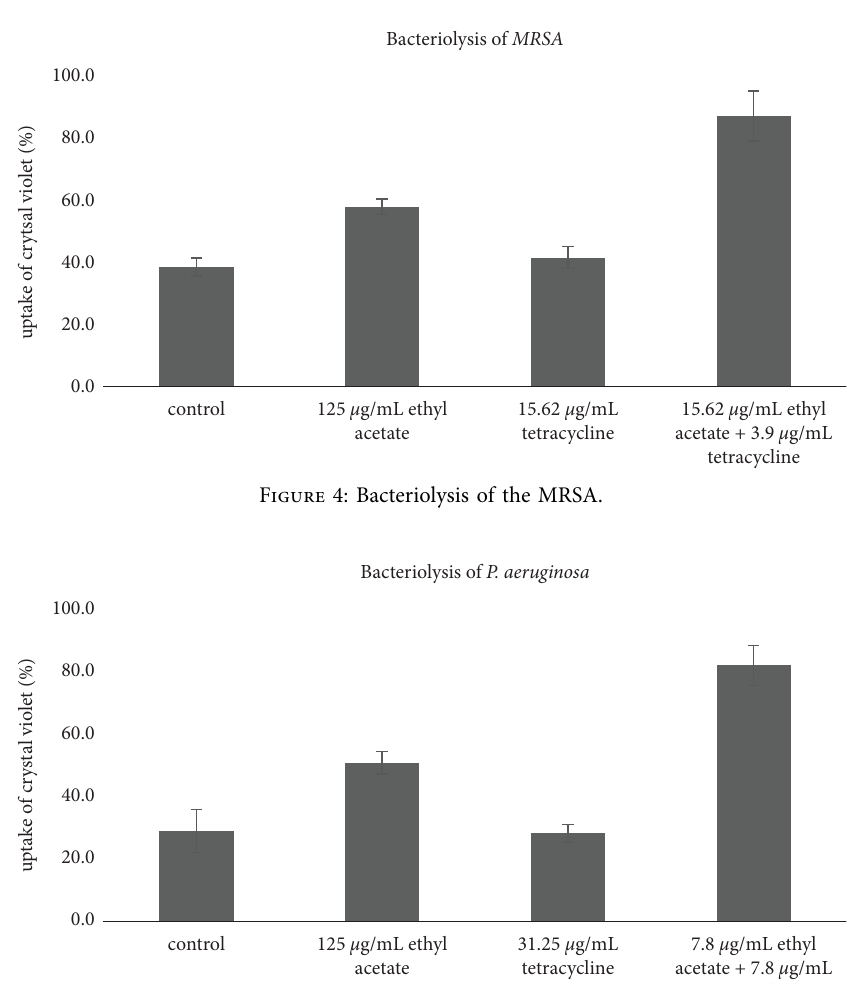
Figure 5: Bacteriolysis of the P.